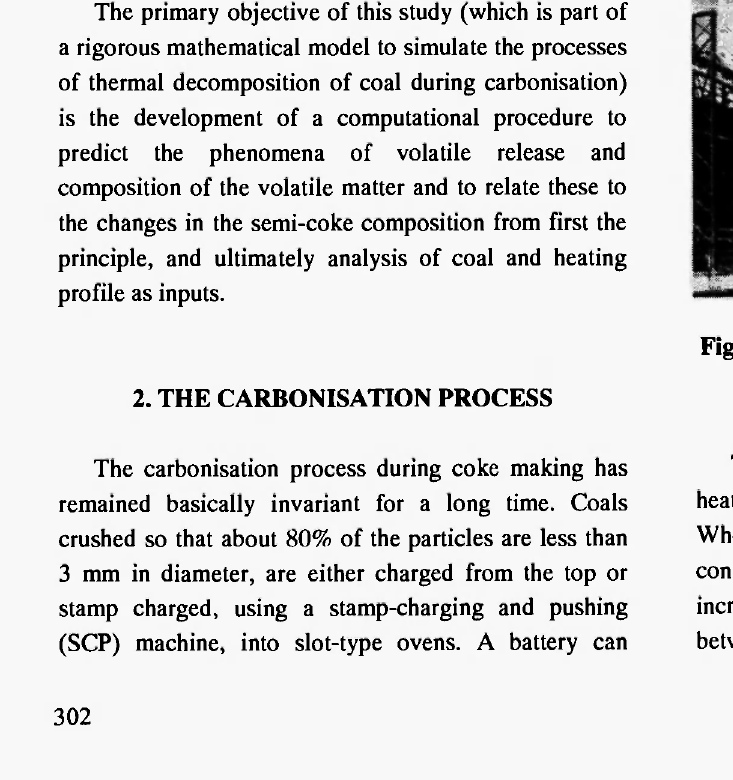
Fig. 1: Stamp-charged coke ovens